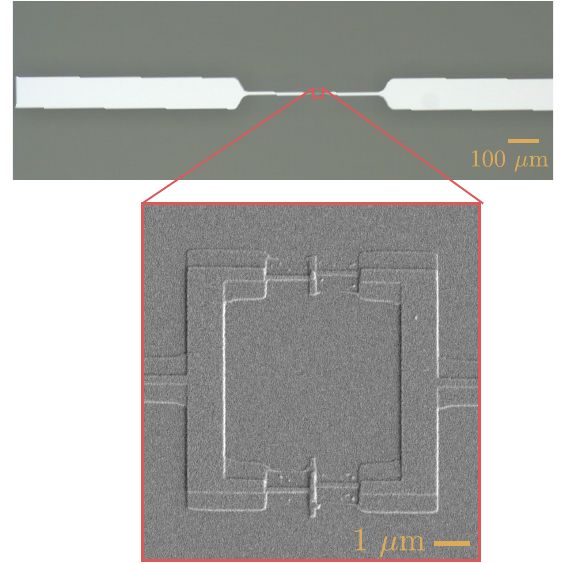
FIG. 10. Upper: an optical image of a qubit fabricated on the same wafer as the experimental device, which is nominally iden- tical. The end of the right pad is not in view but is symmetric with the pad on the left. Lower: a scanning-electron-microscope image of the SQUID loop of the optically imaged device, in which the difference of the areas of the two Josephson junc- tions is apparent. The image contrast is enhanced using the GIMP image-manipulation software. The qubit is fabricated using the bridge-free technique in a liftoff process as described in Refs.